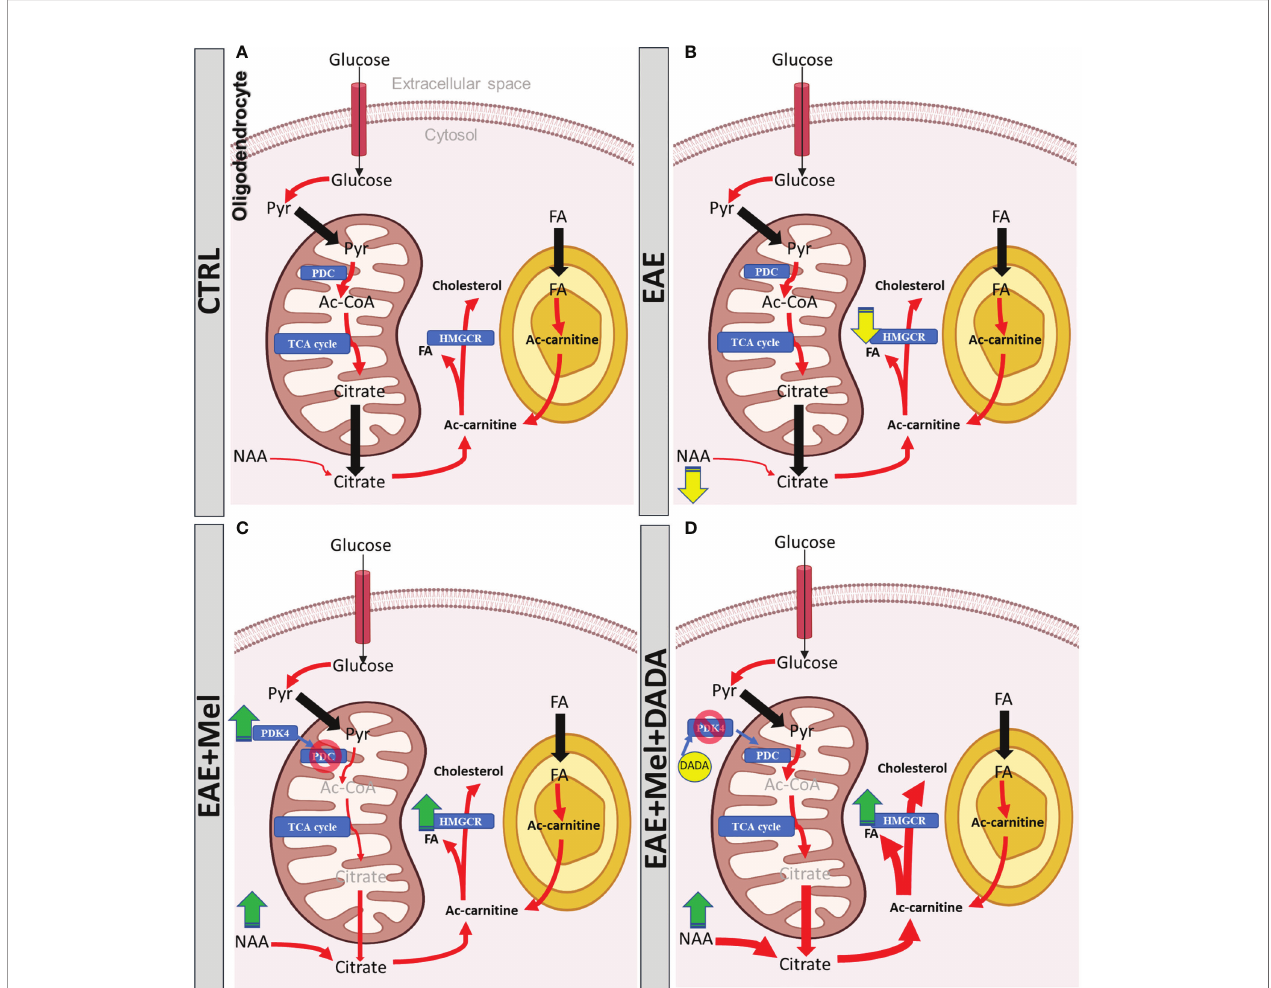
FIGURE 8 | The models of Melatonin and DADA effects on FA synthesis during remyelination. (A) In physiological conditions, citrate is produced from imported glucose or pyruvate and from imported NAA into the oligodendrocyte to be utilized as a substrate for FA synthesis required from myelination. Proper function of PDC warranty the synthesis of this citrate. (B) During EAE, PDC function remains intact, which is involved in pyruvate conversion into citrate. The other precursor of citrate, NAA, shows signi fi cant reduction, which is suggested to reduce the citrate level, which might slow down FA synthesis and subsequently the remyelination in EAE mice. (C) Melatonin therapy recovers the reduced level of NAA in EAE mice in order to increase the citrate levels required for FA synthesis. On the other hand, melatonin increases PDK4 expression which acts as an inhibitor of PDC, leading to suppression of citrate synthesis. However, the oligodendrocyte still imports the NAA from axons or any other unknown sources to have enough citrate for FA synthesis. (D) Since PDC inhibition by melatonin could be considered as a side effect of melatonin therapy, DADA administered in combination with melatonin would suppress the function of PDK4 and rescue the PDC from inhibiting PDK4 function. This leads to the recovery of citrate synthesis by the PDC-dependent pathway, while NAA, another source of citrate, is already high due to melatonin, resulting together into the fast formation of suf fi cient sources for FA synthesis in remyelination. Yellow arrow shows reduction, green arrow shows increase, red arrow shows conversions; blue rectangle shows the enzymes, Pyr, pyruvate; FA, Fatty acid; PDK-4, pyruvate dehydrogenase kinase-4; PDC, pyruvate dehydrogenase complex;, Ac-CoA, acetyl-CoA; HMGCR, 3-hydroxy3-methylglutaryl-coenzyme-A reductase; TCA, tricarboxylic acid cycle; NAA,